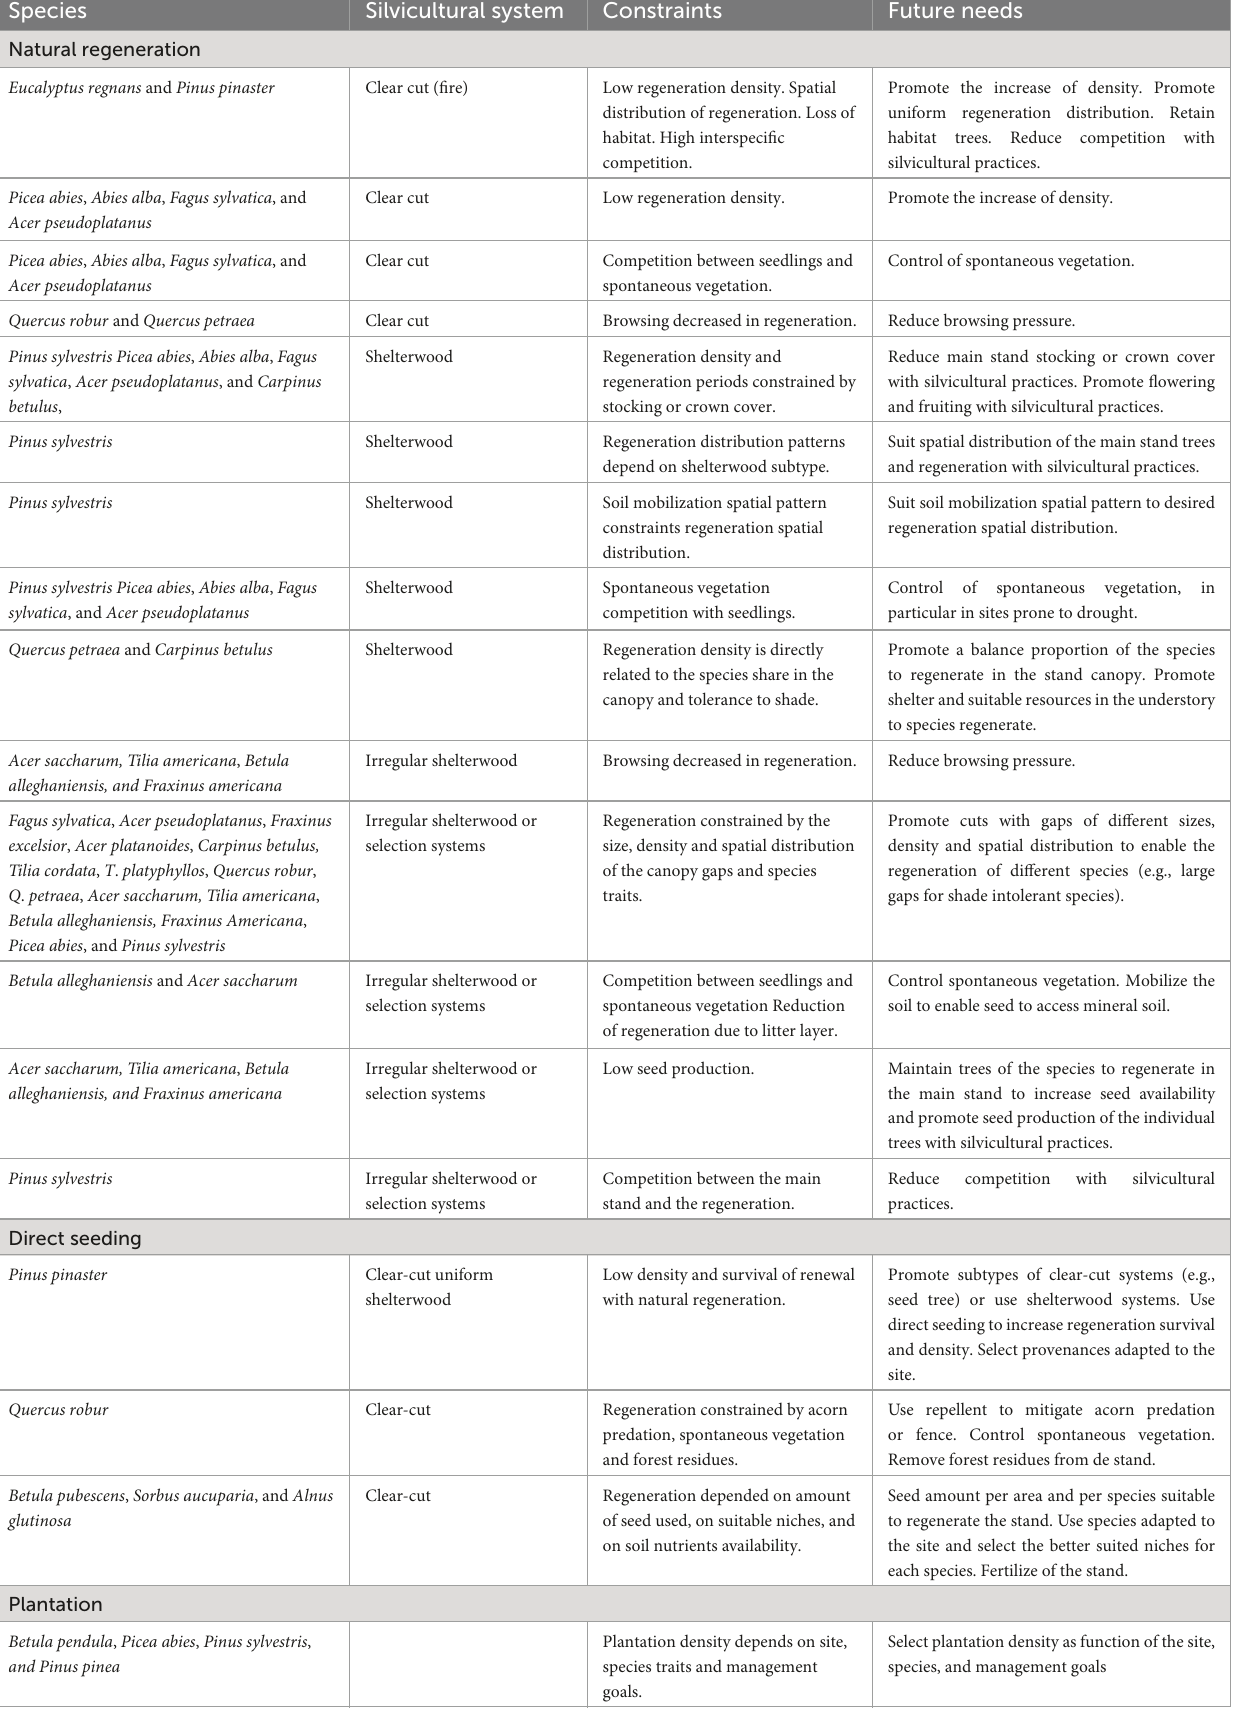
TABLE 1 Constraints and future needs in the regeneration of forest